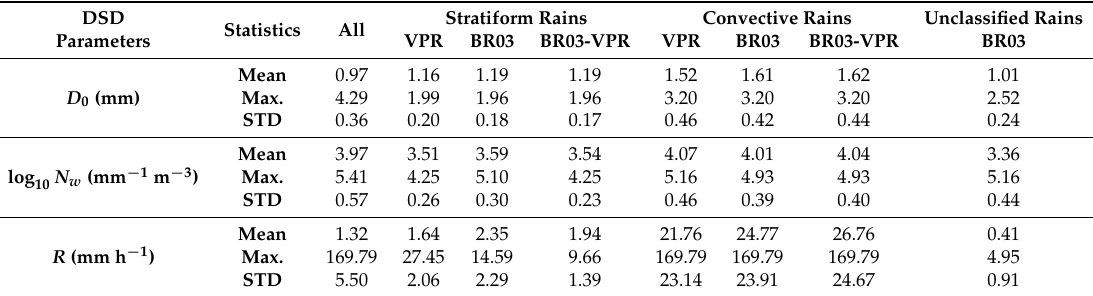
Figure 6. ( Top ) Droplet number concentration distributions versus droplet size for the stratiform, convective, and unclassified rains at the Jincheon site through the VPR, BR03, and BR03-VPR methods. ( Bottom ) As for the top panel, but over three different diameter ranges: small drops (left panel), medium drops (middle panel), and large drops (right panel). N w , and R measurements for all the rainfall Table 2. D 0 , log 10